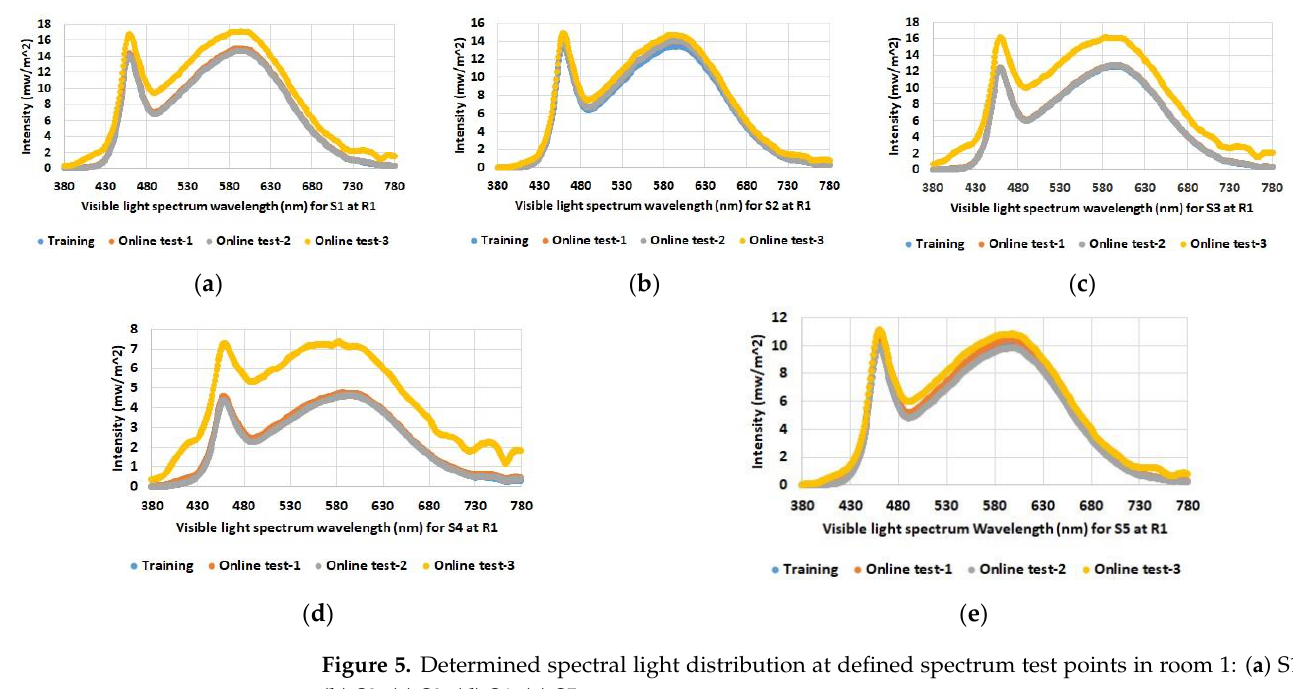
Figure 5. Determined spectral light distribution at defined spectrum test points in room 1: ( a ) S1; ( b )